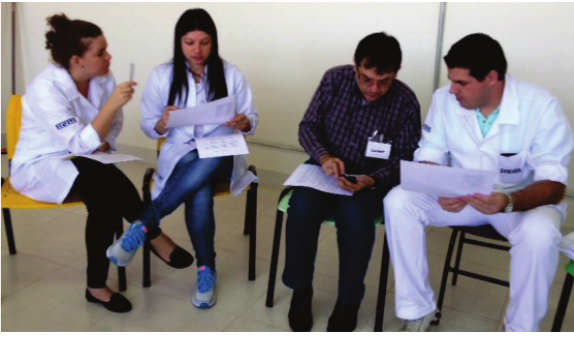
Fig. 9. Healthcare professionals evaluating the